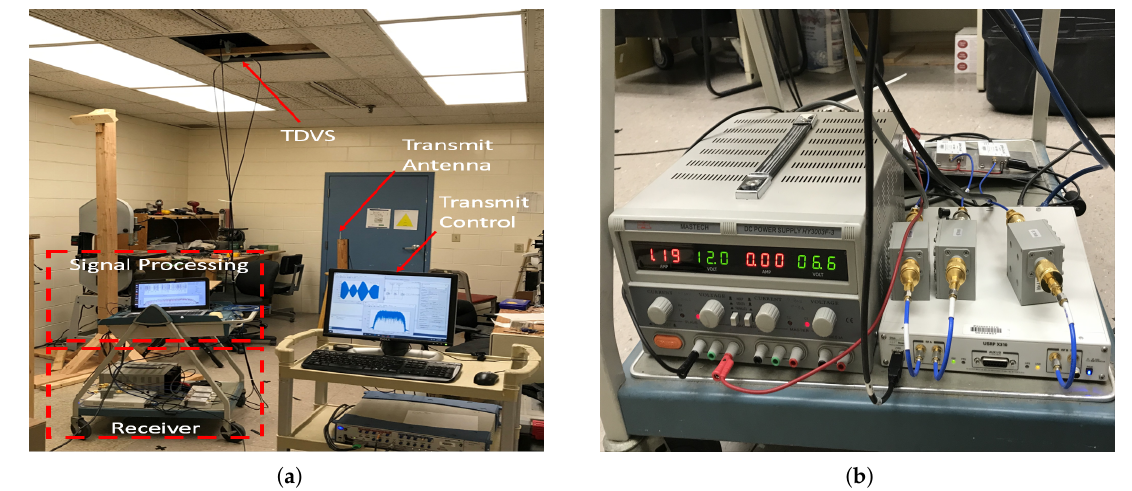
Figure 14. Experimental configuration in hardware area with ( a ) the hardware configuration and ( b ) signal conditioning of the SDR front-end.